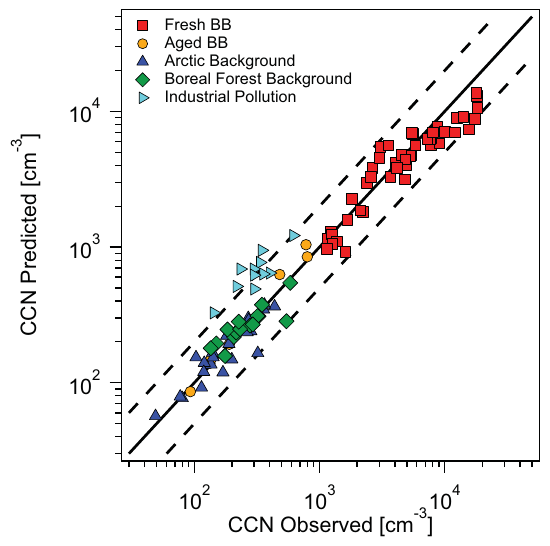
Fig. 6. CCN closure plot for each source type assuming externally mixed aerosol with soluble organics. Solid line represents the 1 : 1 agreement, while the dashed lines represent ± 50% error